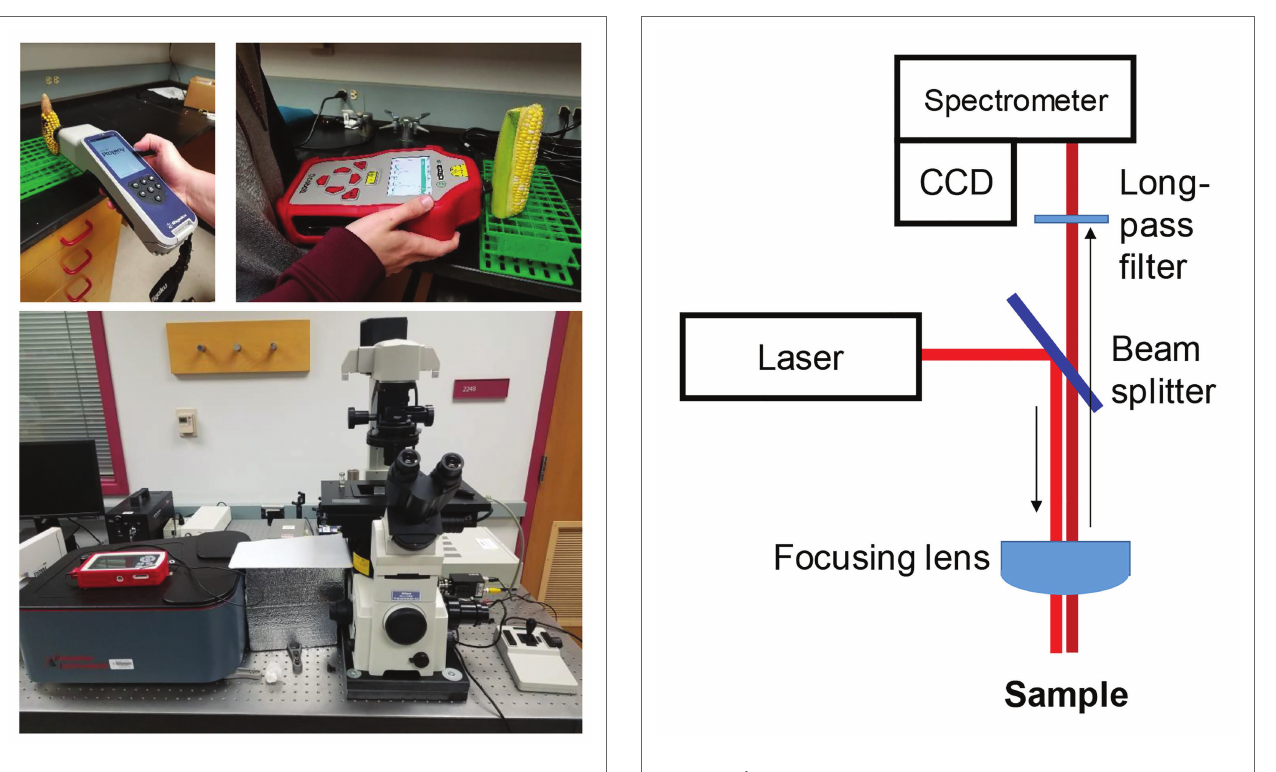
FIGURE 1 | Two commercially available hand-held Raman spectrometers with 1,064 nm (left) and 830 nm (right) excitations (top) and a bench-top home-built confocal Raman microscope (bottom).